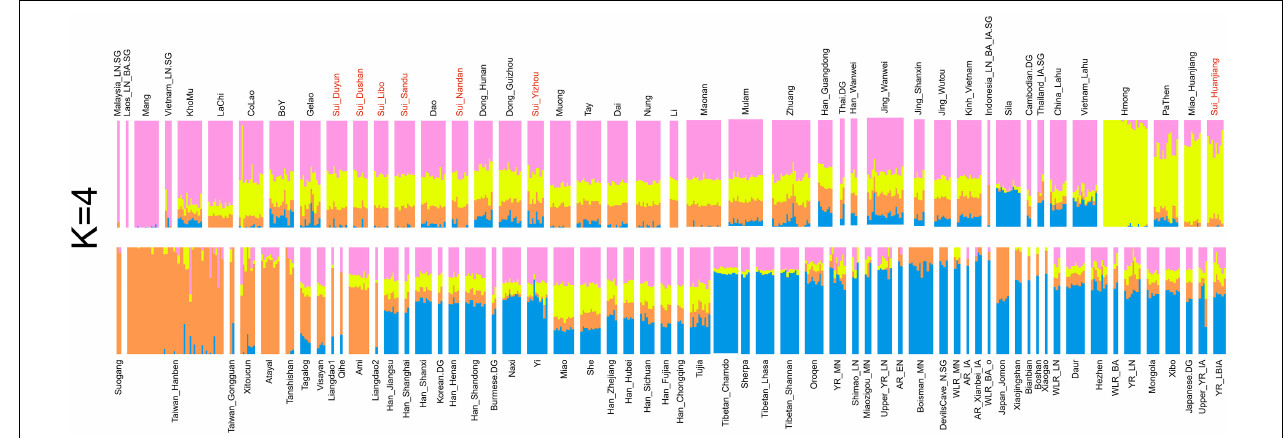
FIGURE 3 | Model-based ADMIXTURE results showed the individual ancestry component composition of studied Sui and reference East Asian and Southeast Asian individuals with the predefined four ancestral sources ( K = 4).